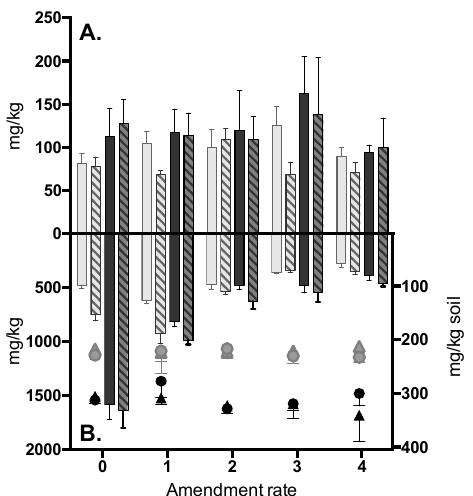
Figure 3. The sodium concentration of shoots ( A ) and roots ( B ) grown in Freeman (light grey) or Bernhill (dark grey) soils amended with KB- (solid) or wood- (cross- hatched) sourced biochars. The sodium of the soils (right axis, (B)) is also plotted for Freeman (light grey) or Bernhill (dark grey) soils amended with KB- (circle) or wood- (triangle) sourced biochars. Amendment rates are represented as 0–4, which correspond to rates of 0%, 3%, 6%, 16%, and 25% by volume for both biochars, 0%, 0.7%, 1.7%, 3.7%, and 8.6% by mass for wood biochar, and 0%, 0.4%, 1.2%, 2.5%, and 5.8% by mass for KB-sourced biochar.